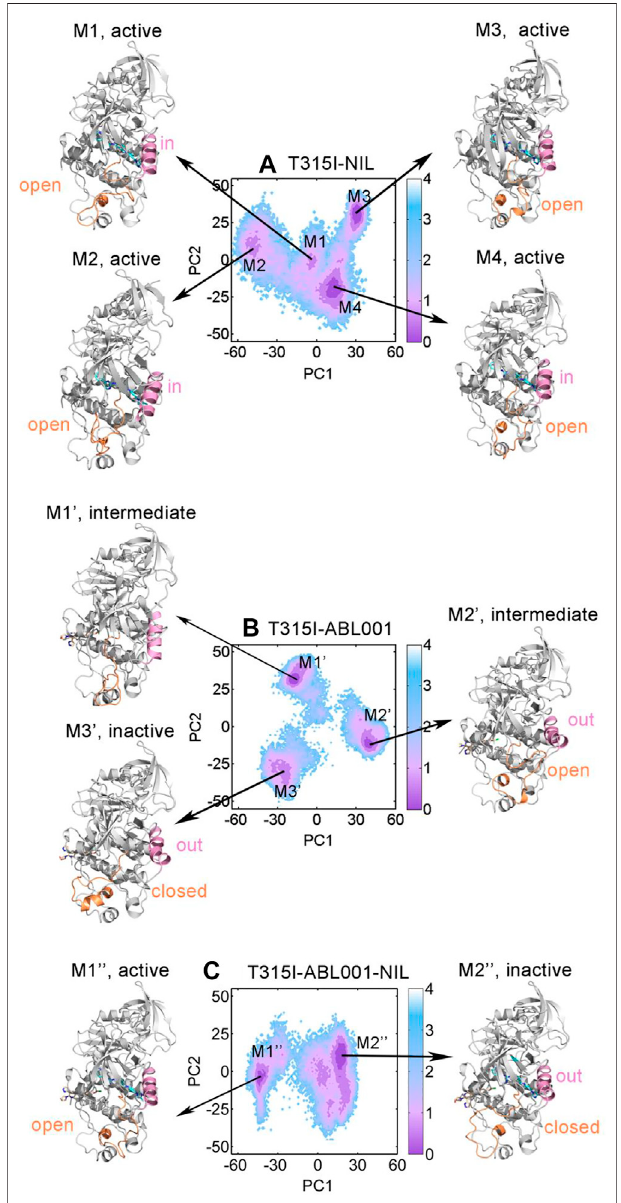
FIGURE 6 | Conformational landscapes of T315I-NIL (A) , T315I- ABL001 (B) and T315I-ABL001-NIL (C) were generated using PCA. Structural comparison of dominant intermediate state of T315I-NIL (M1, M2, M3, and M4), T315I-ABL001 (M1 ′ , M2 ′ , and M3 ′ ) and T315I-ABL001- NIL (M1 ″ and M2 ″ ), with the A-loop colored in orange and α C-helix in pink.